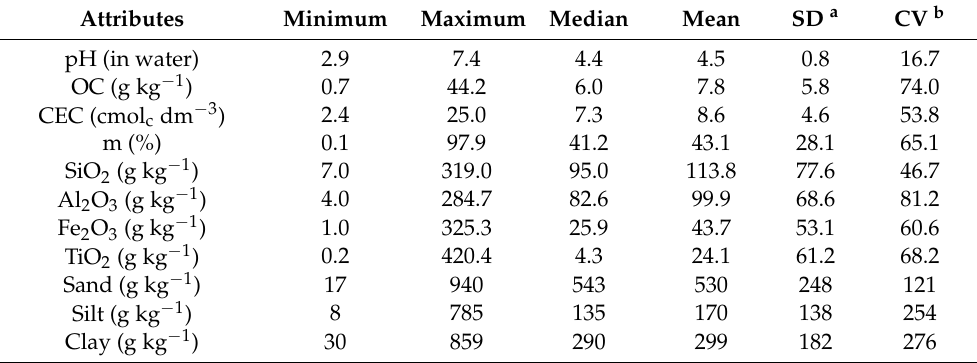
Table 1. Chemical attributes and granulometry of soils (0–0.2 m layer) in the State of Par á